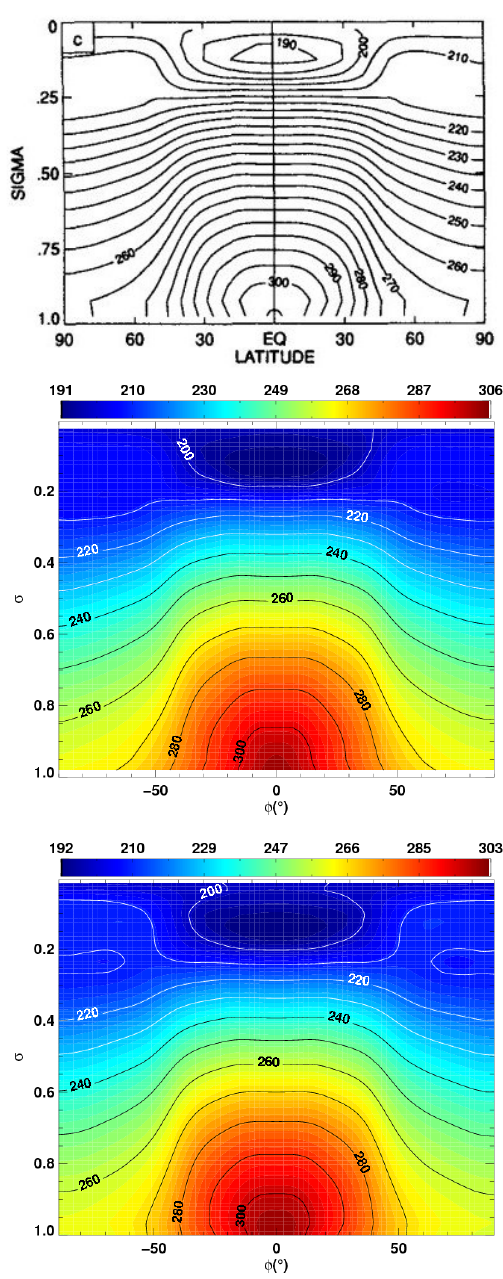
Fig. 3. Same as Figure 2 but for zonal wind (ms − 1 ).